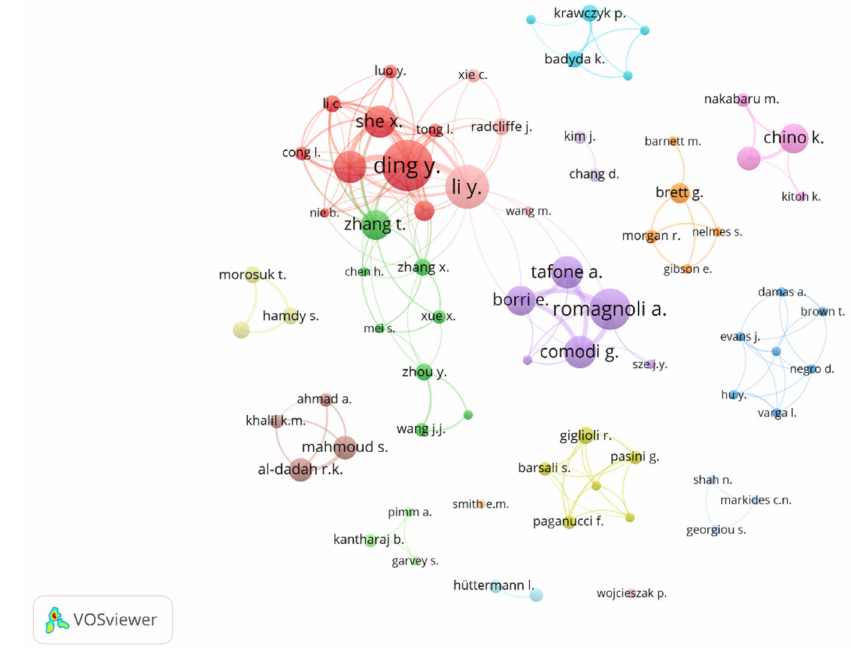
Figure 11. Network of the di ff erent authors elaborated with